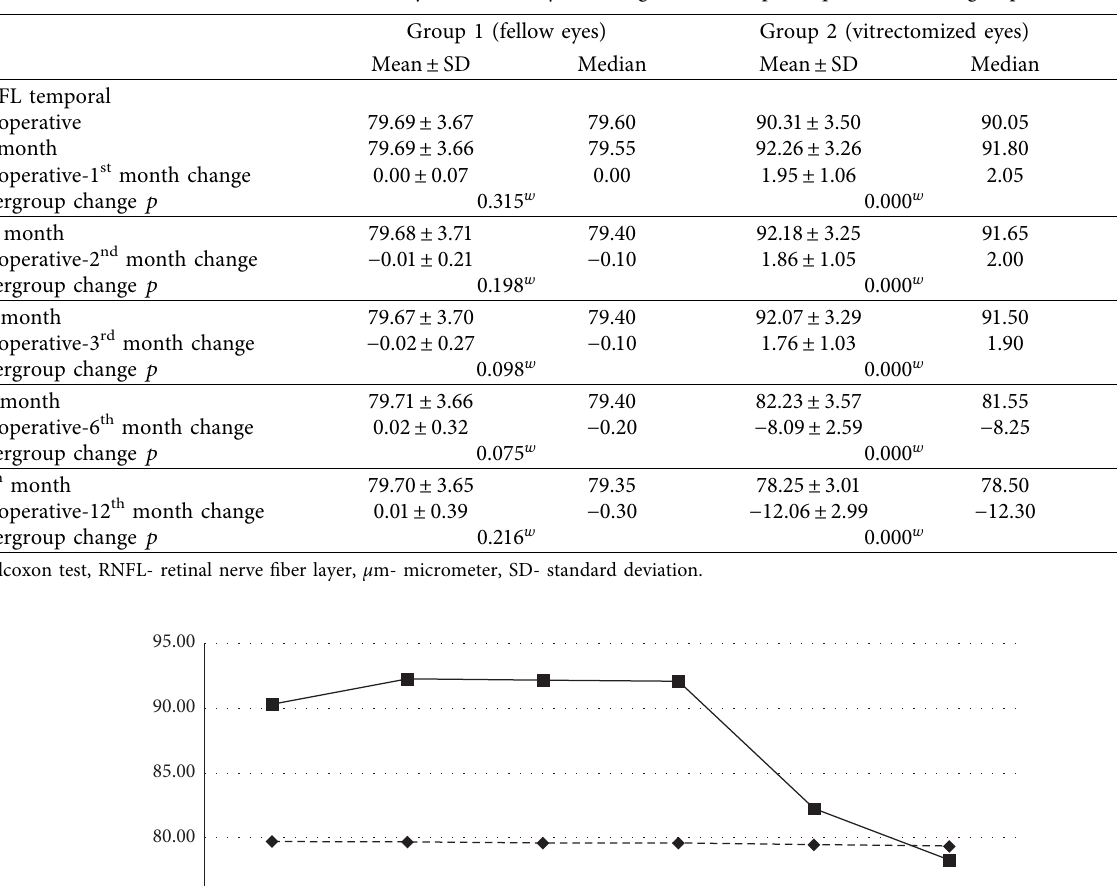
Table 4: Retinal nerve fiber layer thickness ( μ m) change in the temporal quadrant of the groups.